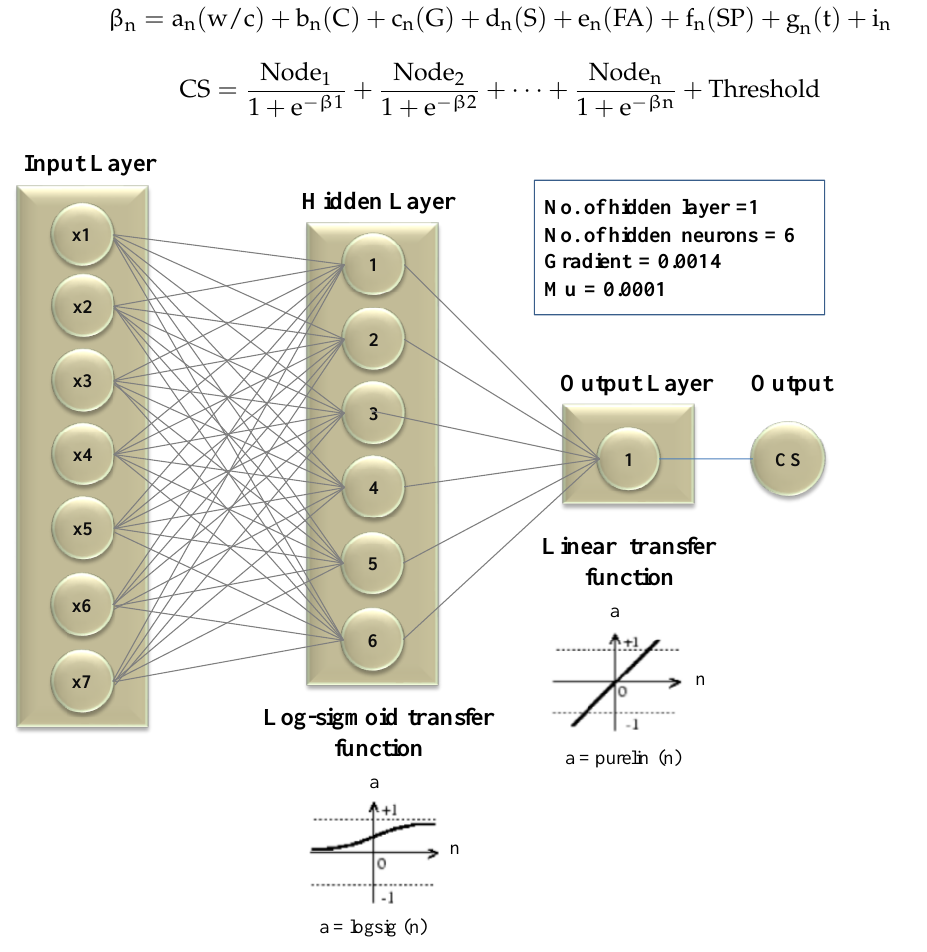
Figure 6. The ideal ANN structure has six hidden neurons and one hidden layer.